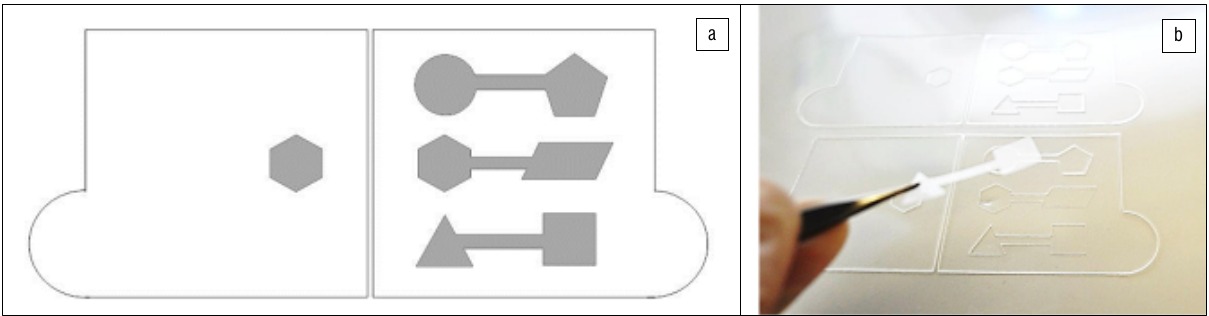
Figure 3: (a) Computer aided design drawing of adhesive layers used for the assembly and sealing of the layers of the design in Figure 1. The shaded areas indicate the fluidic flow pathways and illustrate the adhesive sections that must be removed. (b) The adhesive layer designs are manufactured using a vinyl cutter and the sections for fluid flow are removed using tweezers.